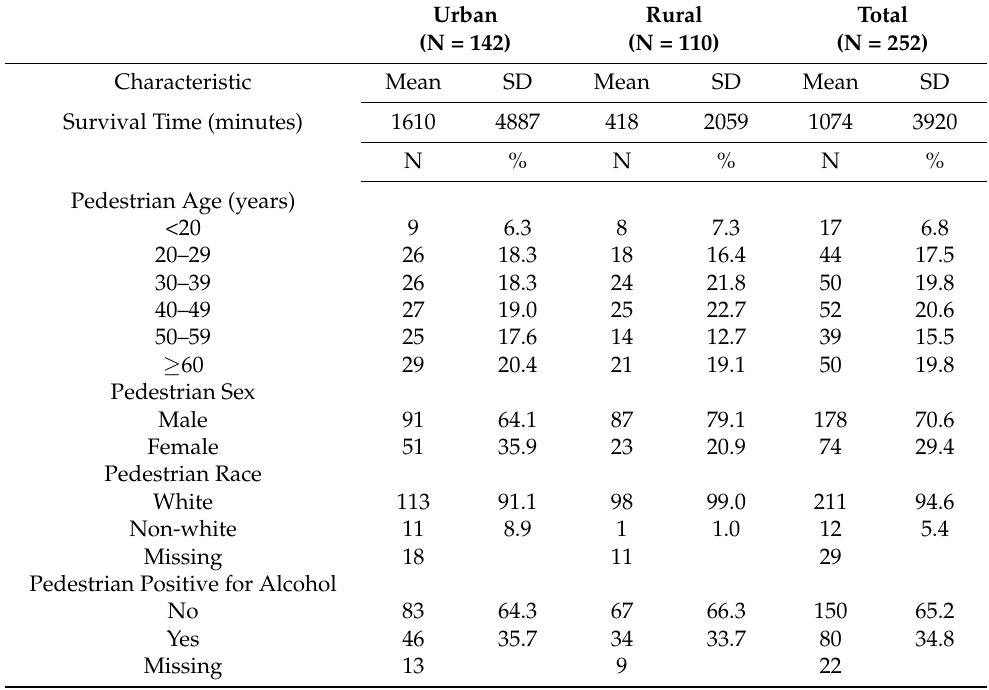
Table A1. Characteristics of fatal pedestrian crashes which occurred in West Virginia: 2009–2019 stratified by rurality